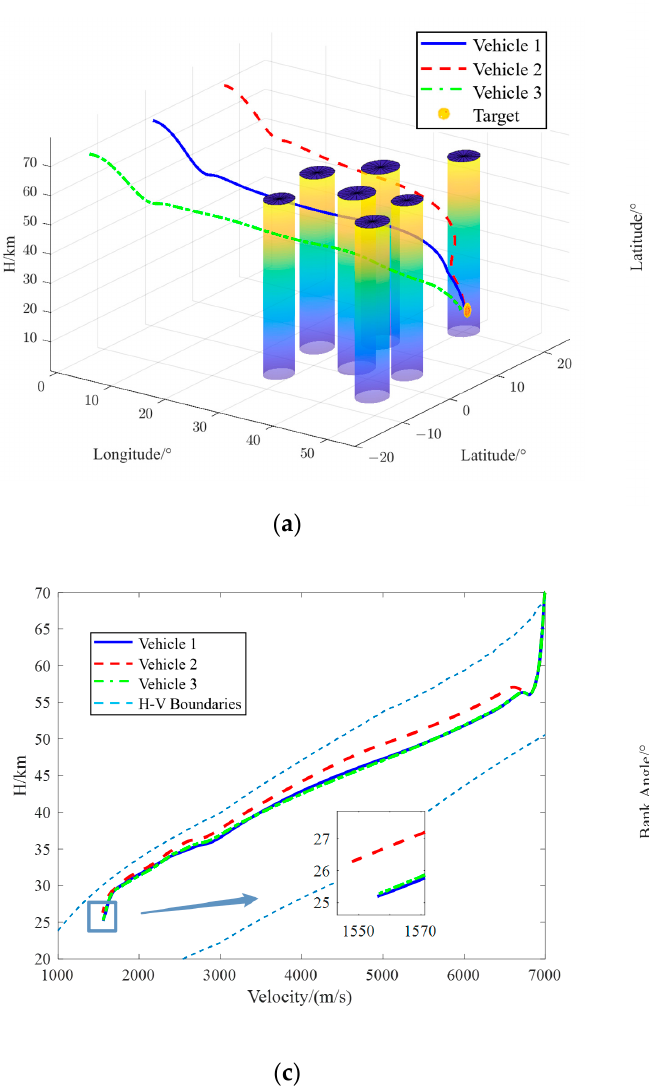
Figure 9. Simulation result of time cooperation. ( a ) The three-dimensional trajectories of three vehicles; ( b ) horizontal trajectories of multiple vehicles in time cooperative guidance simulations; ( c ) longitudinal trajectories of multiple vehicles in time cooperative guidance simulations; ( d ) bank angle profiles of multiple vehicles in time cooperative guidance simulations.